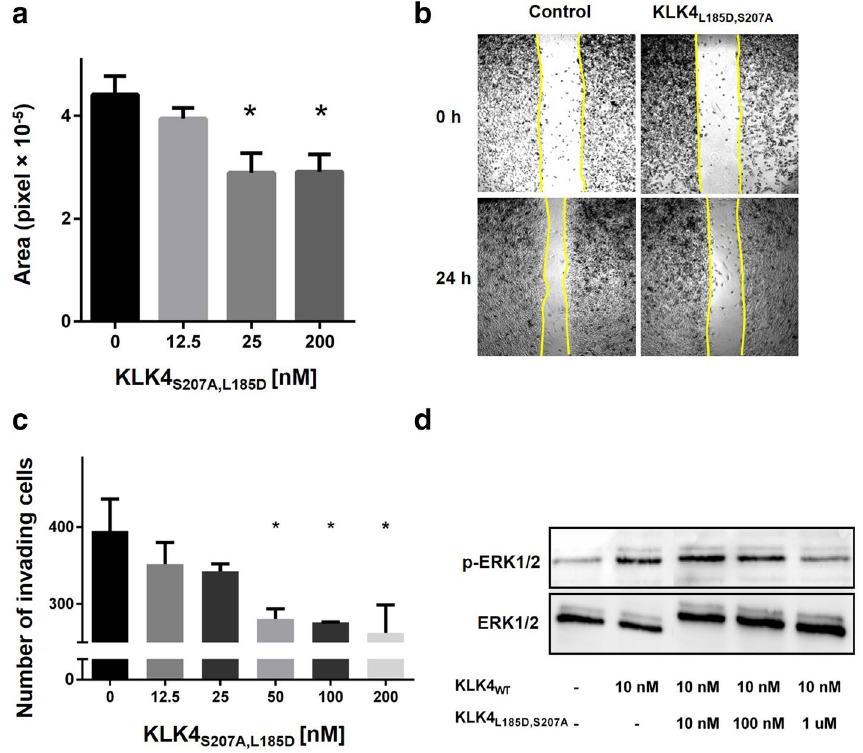
Figure 5. Inhibition of cell invasion, migration and downstream signaling of melanoma cells by KLK4 S207A,L185D . ( a ) Inhibition of WM3682 melanoma cell migration as determined by a scratch assay. A monolayer of WM3682 cells was scratched linearly. After the scratch had been generated, the cell culture was supplemented with 0, 12.5, 25 and 200 nM KLK4 L185D,S207A, and the cells were then imaged by a phase-contrast microscopy, at 0 and 24 h after the scratch had been made. The relative area covered by cells for each treatment was calculated as the ratio of the scratch gap at 24 h and the original gap at 0 h. The results are presented as means ± SE (n = 3). * p < 0.05 compared with the untreated control by ANOVA. ( b ) Representative images of cells that had migrated (from panel a ). ( c ) Inhibition of invasion of WM3314 melanoma cells by KLK4 L185D,S207A was determined in a Boyden chamber invasion assay. The numbers of cells that migrated through the membrane were counted at 18 h post treatment with 0, 12.5, 25, 50, 100 and 200 nM KLK4 L185D,S207A . The results are presented as means ± SE (n = 3). * p < 0.05 compared with the untreated control by ANOVA. ( d ) Inhibition of ERK1/2 activation by KLK4 L185D,S207A . WM3682 cells were treated for 15 min with PBS, 10 nM KLK4 WT , or with a mixture of 10 nM